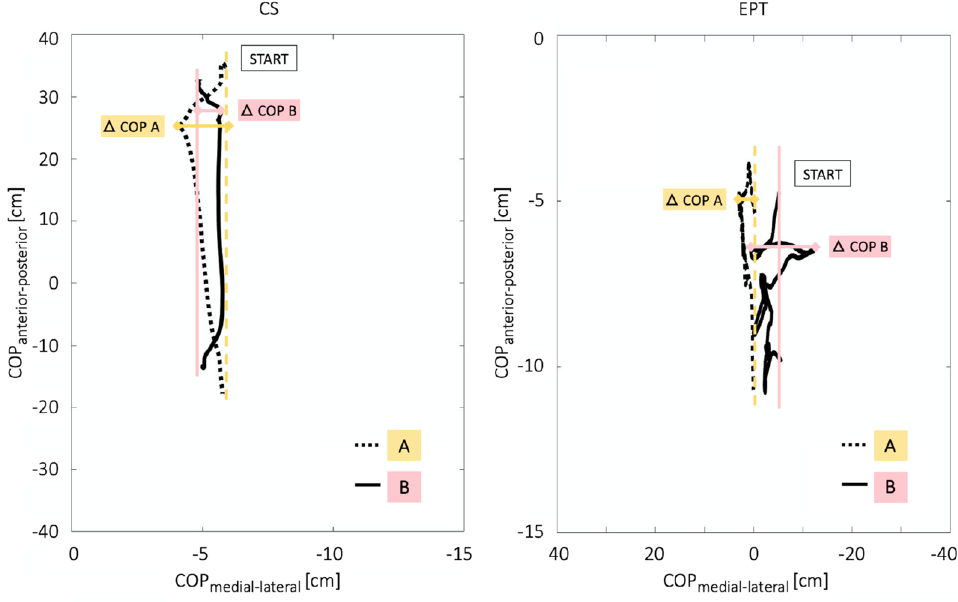
Figure 3. Representation of the postural sway determined by the COP in medial–lateral and anterior–posterior directions during the CS and EPT. The initial COP positions are indicated (START). Data are presented as means for both